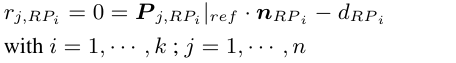
Figure 2. Arrangement of five RP sensitive to the lever arm ( t x , t y , t z ) | b s and boresight angle ( κ, ϕ, ω ) | b s .